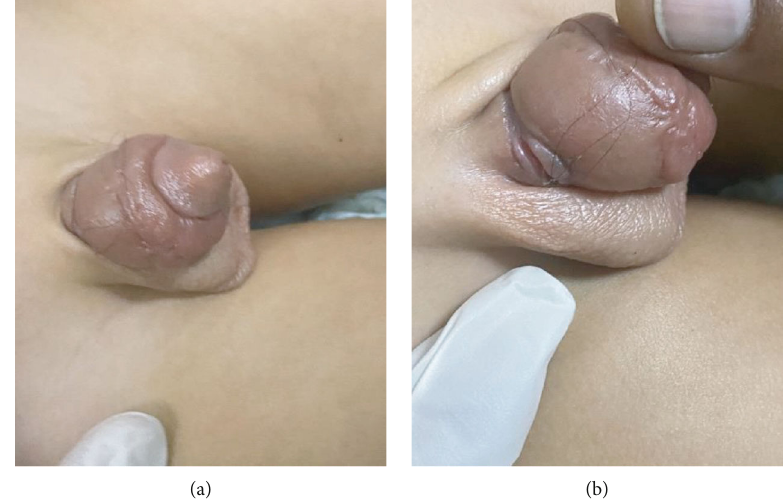
Figure 1: (a) Appearance of penile hair tourniquet syndrome at time of diagnosis. (b) Causative factor: hair strand of mother.